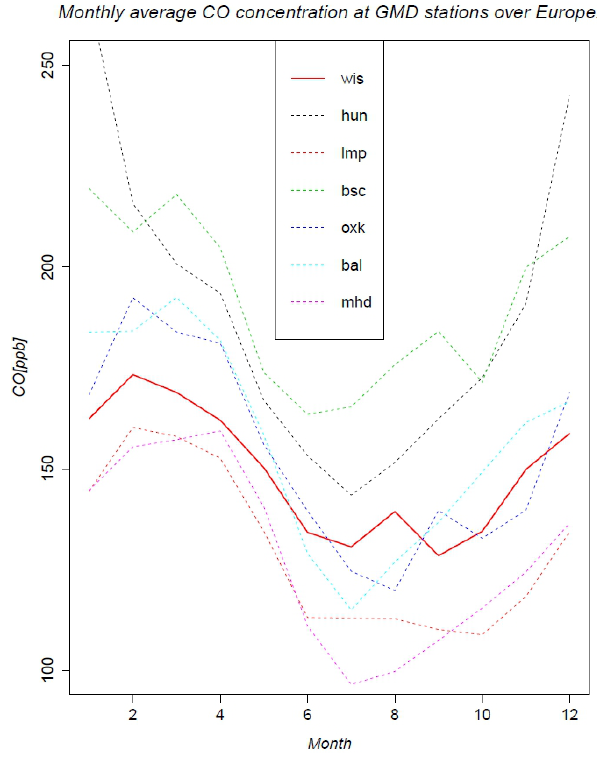
Fig. 1. CO monthly means for Sde-Boker (31.13 ◦ N, 34.88 ◦ E, 400m) along with other European GMD stations (solid red line for WIS, dashes lines for other European